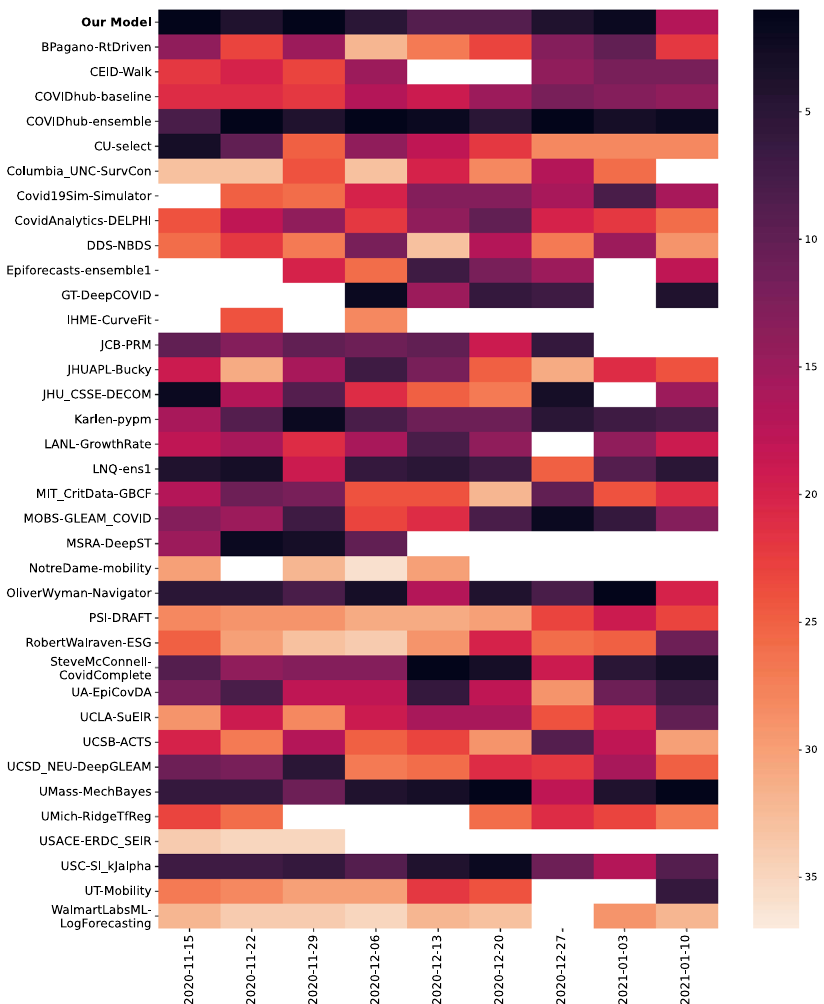
Fig. 3 Model rankings for incident death MAPE. Model rankings for incident death MAPE in the prospective evaluation period. The darker the color, the higher the ranking of the model is for the corresponding prediction